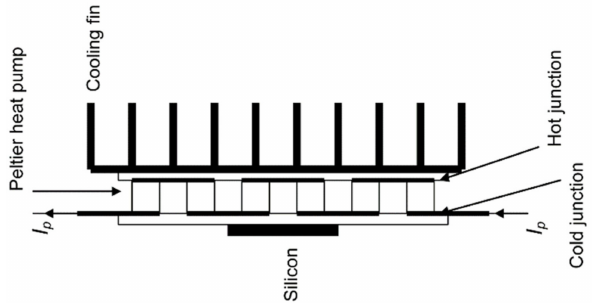
Figure 2. Chip–Peltier heat pump—cooling fin